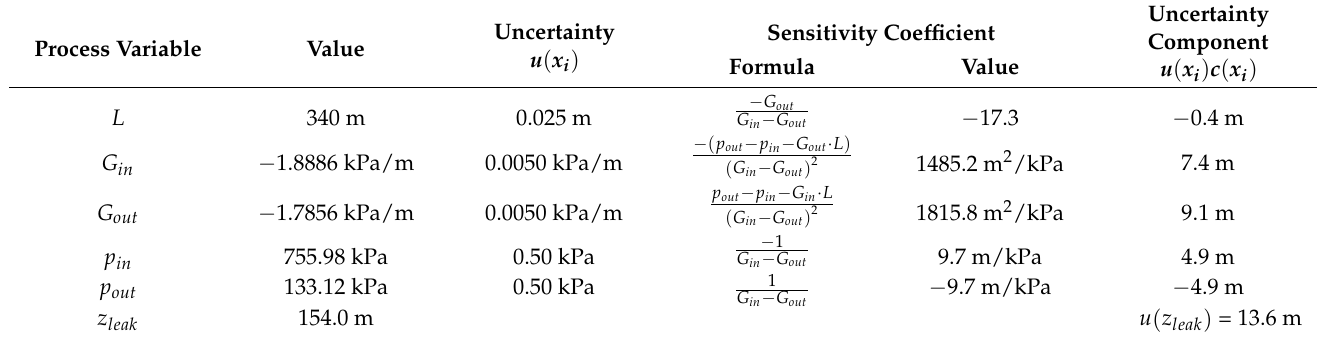
Table 6. Uncertainty budget for leak location